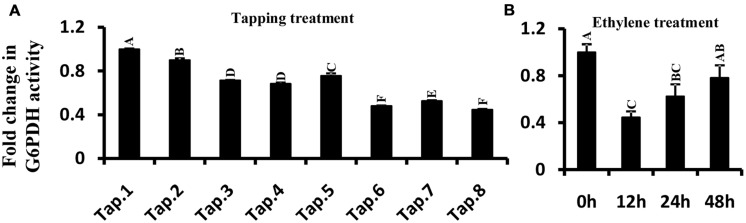
Effect of tapping (A) and ethylene treatment (B) on Hevea brasiliensis G6PDH enzyme activity in latex. Different capital letters indicate a significant difference at 0.01 level.